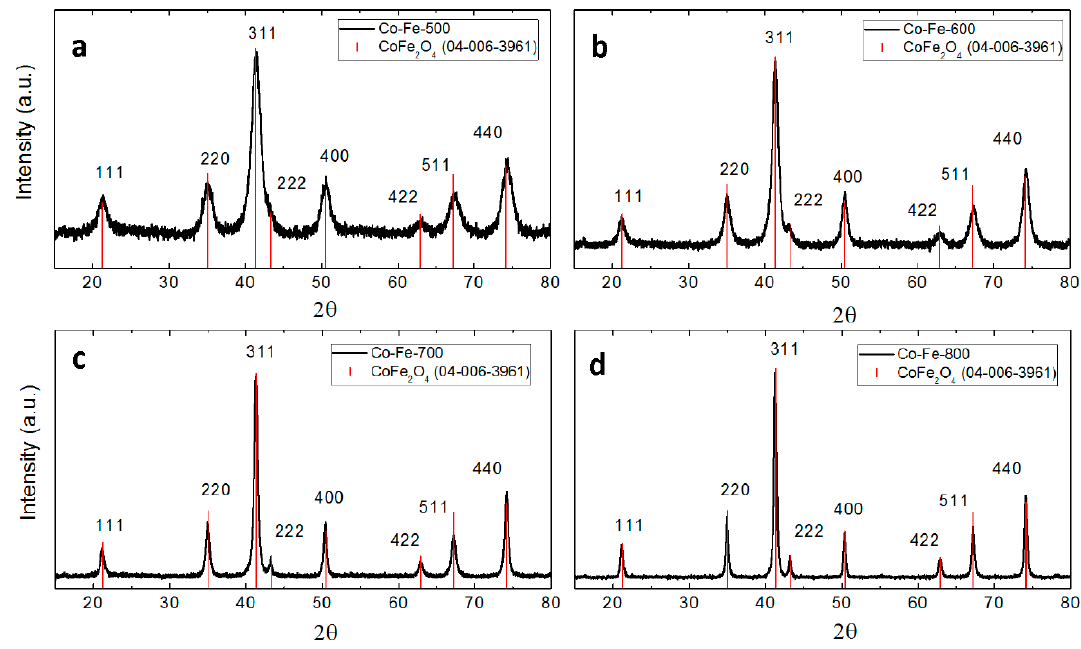
Figure 6. XRD patterns of prepared nanoparticles: ( a ) Co-Fe-500, ( b ) Co-Fe-600, ( c ) Co-Fe-700 and ( d ) Co-Fe-800.